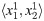
Orientation estimation.(a) The illustration of Algorithm 1. Here I
1 and I
2 denote the image plane of Camera 1 (blue) and Camera 2 (red) respectively. The line-segment ⟨x11,x21⟩ (blue) denotes the ellipse’s major axis in I
1. And the line-segment ⟨x12,x22⟩ (red) denotes the ellipse’s major axis in I
2. The projection rays of those end-points define two plane Φ1 and Φ2 respectively, e.g. two blue rays define Φ1. The orientation O is computed from the direction of the cross line (the longer green line) between two planes Φ1 and Φ2. Here all definitions are defined in the world coordinate system. (b) The orientation is problematic. The measurement is drawn in red, and red dashed lines are the major-axis and minor-axis of its ellipse. A generative shape according to the fly’s location X and orientation O is re-projected into the camera view (see S2 Fig for the generative shape model.). The green pixels are re-projected pixels. Yellow pixels are identical pixels. (c) The error ϵ as a function of the ratio γ. Here γ defines the length ratio between the major-axis and the minor-axis of an ellipse.